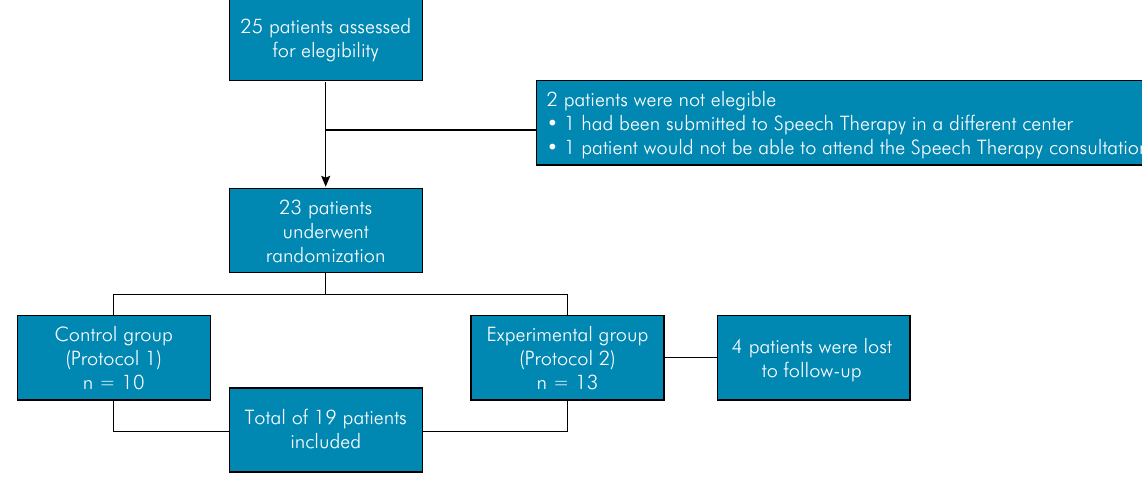
Figure 1. Patient randomization